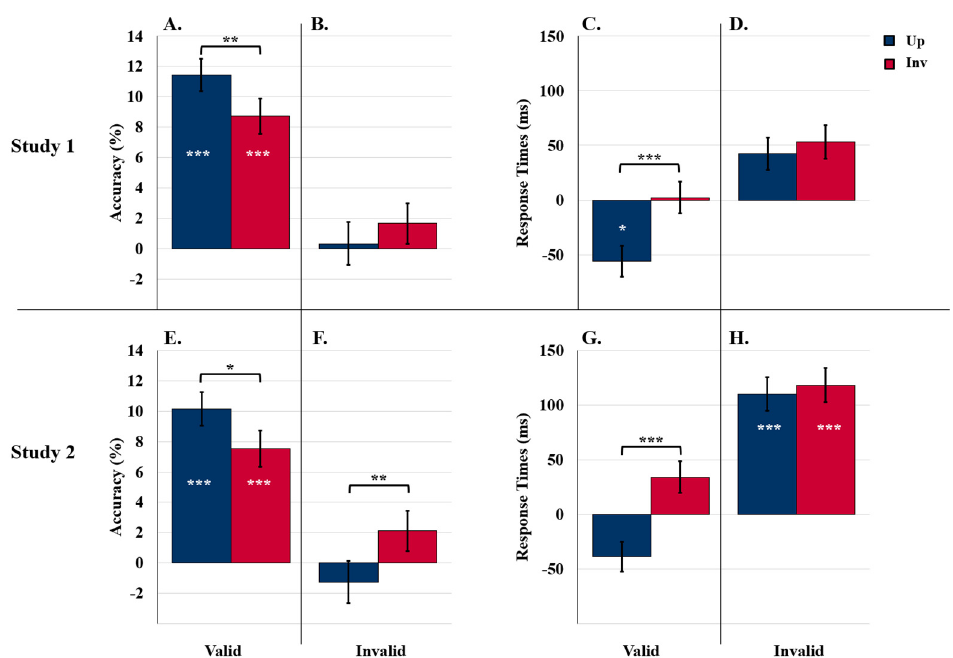
Figure 5. Results for comparisons to control. ( A – D ) Comparisons to Study 1 and ( E – H ) comparisons to Study 2. Object detection accuracy difference scores following valid ( A , E ) and invalid ( B , F ) labels. Detection RT differences scores following valid ( C , G ) and invalid ( D , H ) labels. White asterisks indicate main effects of condition (experimental vs. control). Brackets and black asterisks indicate two-way interactions between conditions (experimental vs. control) and orientation. Error bars represent pooled standard errors. *** indicates p < 0.001, ** indicates p < 0.03, and * indicates p < 0.05.